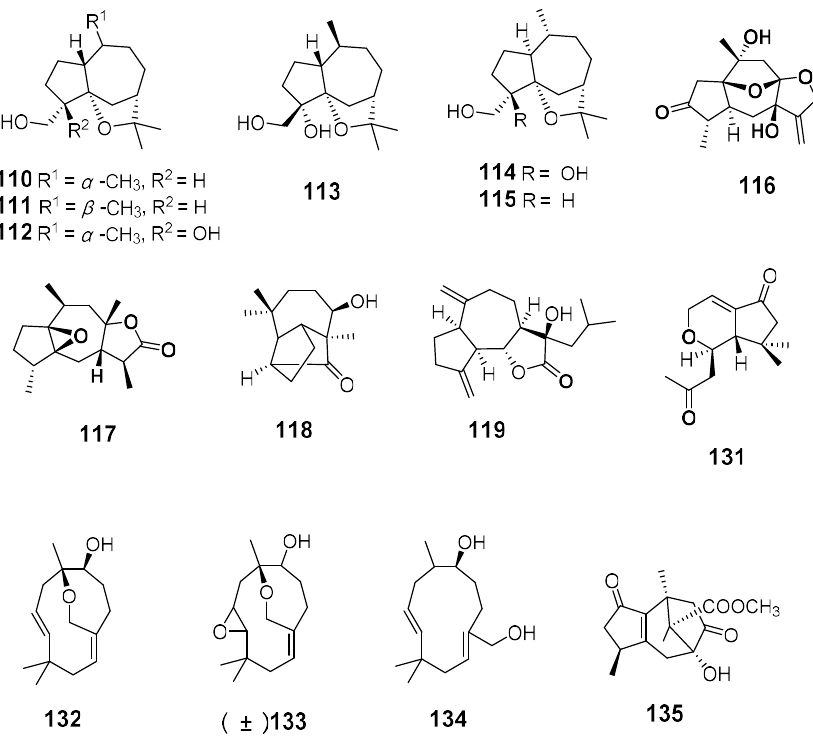
Figure 6. Structures of sesquiterpenes identified in agarwood.